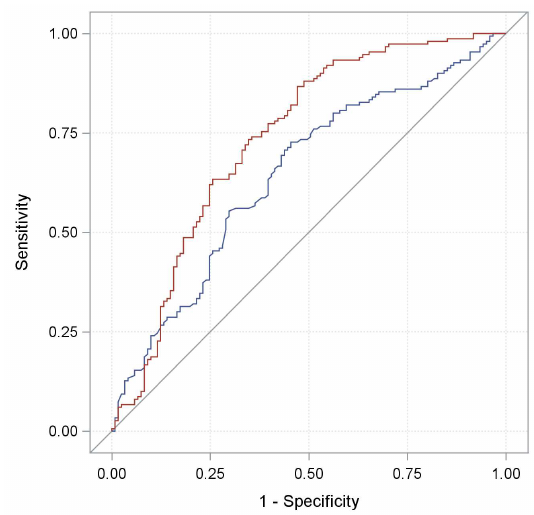
Figure 4. ROC curves of the proposed predictor (red line, AUC: 0.737) and N/L ratio one (blue line, AUC: 0.645).